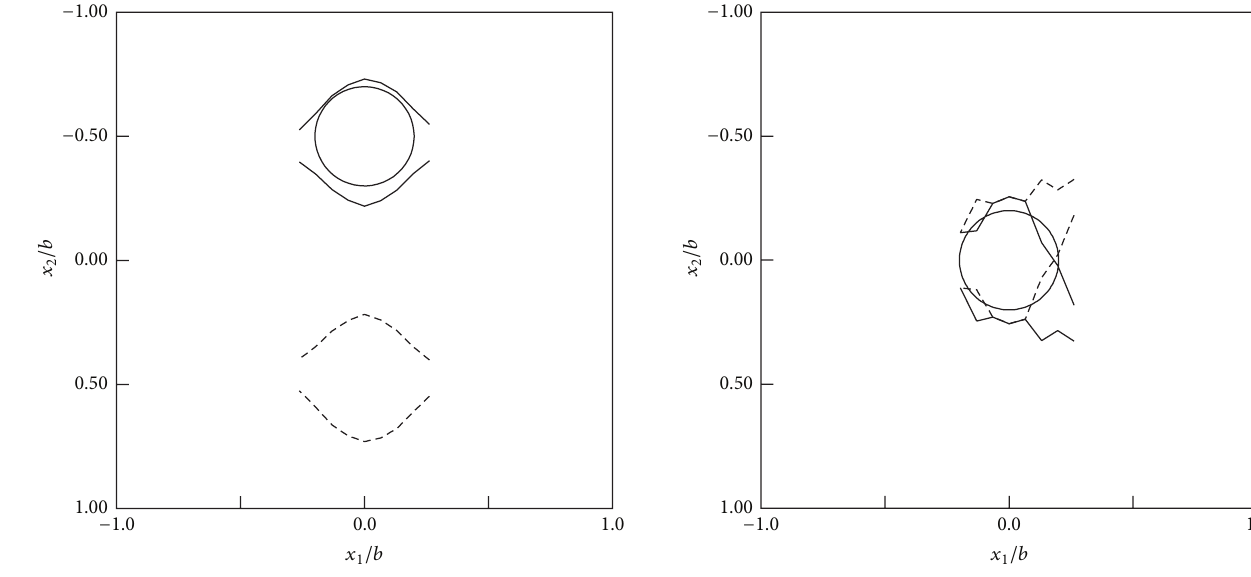
Figure 6: Reconstructed cavity with 𝑅 1 = 𝑅 2 = 0.2𝑏 , ̃𝑥 2 = 0.0 .